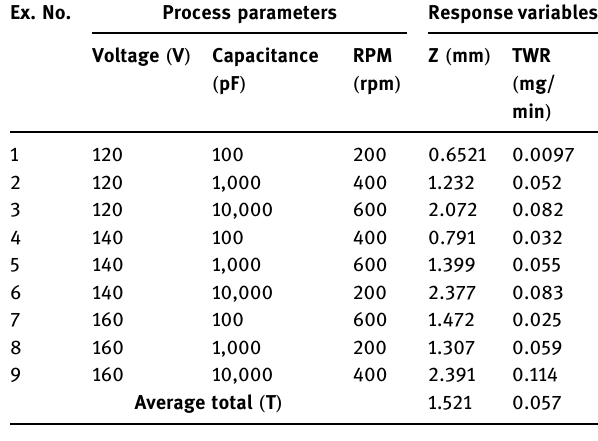
Figure 3: Grain structure in the coating.